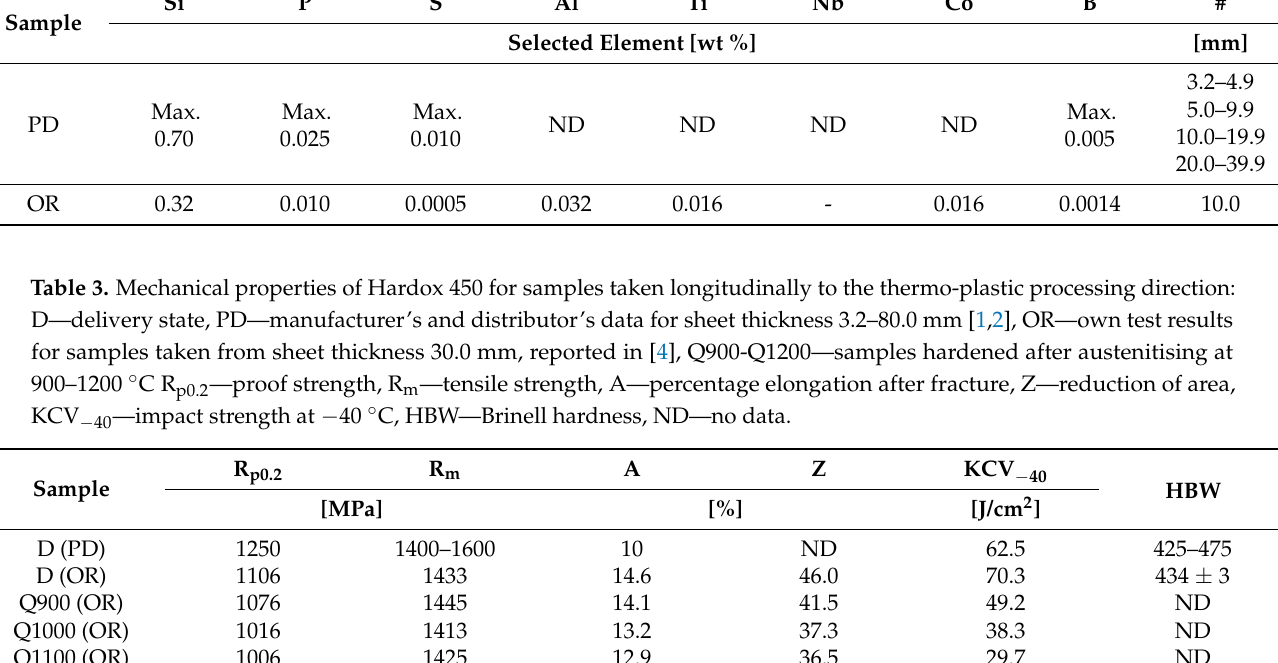
Table 2. Chemical composition of Hardox 450: PD—manufacturer’s data [1], OR—results of own research, #—plate thickness, ND—no data.